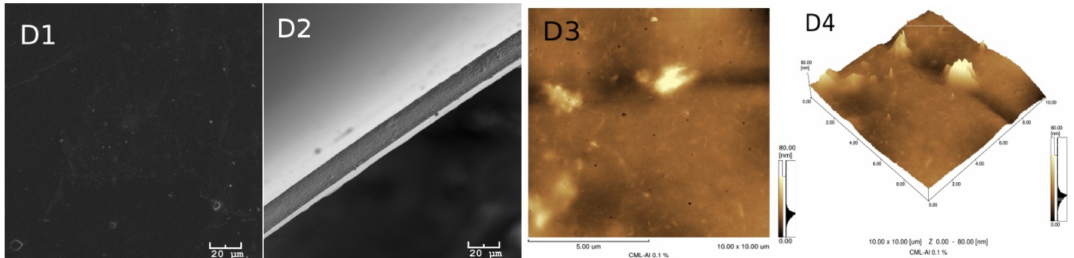
Figure 2. The letters A, B, C and D refer to the membranes of groups I and II described in Figure 1. Numbers 1, 2, 3 and 4, in A1 through D4, refer to surface SEMs (1) and fracture (2) of the membranes and the two-dimensional (3) and three-dimensional (4) AFM of the membranes of group I.